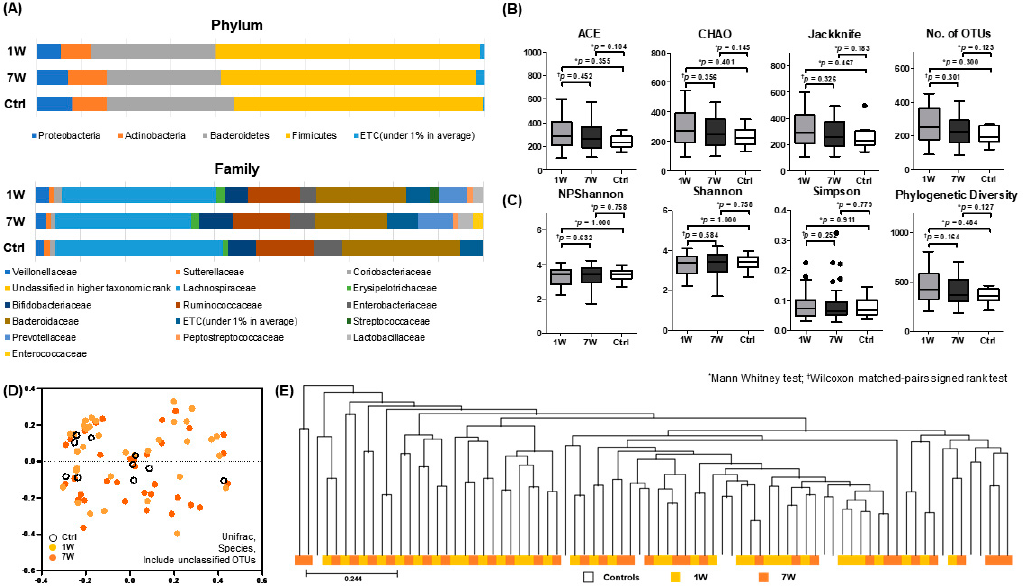
Figure 3. Microbial analysis of fecal samples obtained from IBD patients at 1–2 weeks (1W) and 7–8 weeks (7W) after infliximab infusion and from healthy volunteers (Ctrl)). ( A ) Stacked bar chart of microbial composition at the phylum and family level; ( B ) microbial richness assessed by ACE, CHAO, Jackknife, and number of OTUs; ( C ) biodiversity index, including NPShannon, Shannon, and Simpson indices, and phylogenetic diversity; ( D ) principal coordinate analysis (PCoA) plot; and ( E ) unweighted pair group method with arithmetic mean (UPGMA) dendrogram.